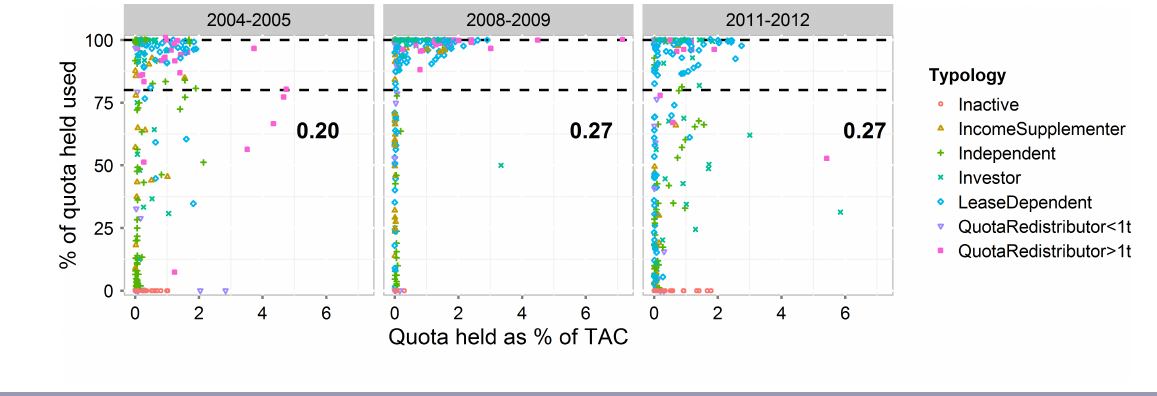
Fig. 7 . Coral trout (CT) quota held compared to quota used at the individual account holder level in three separate financial years with horizontal broken lines denoting usage at 80% and 100% (gaps of 20% and 0%, respectively). The correlation coefficient between proportion of quota held and size of gap observed is given for each year in